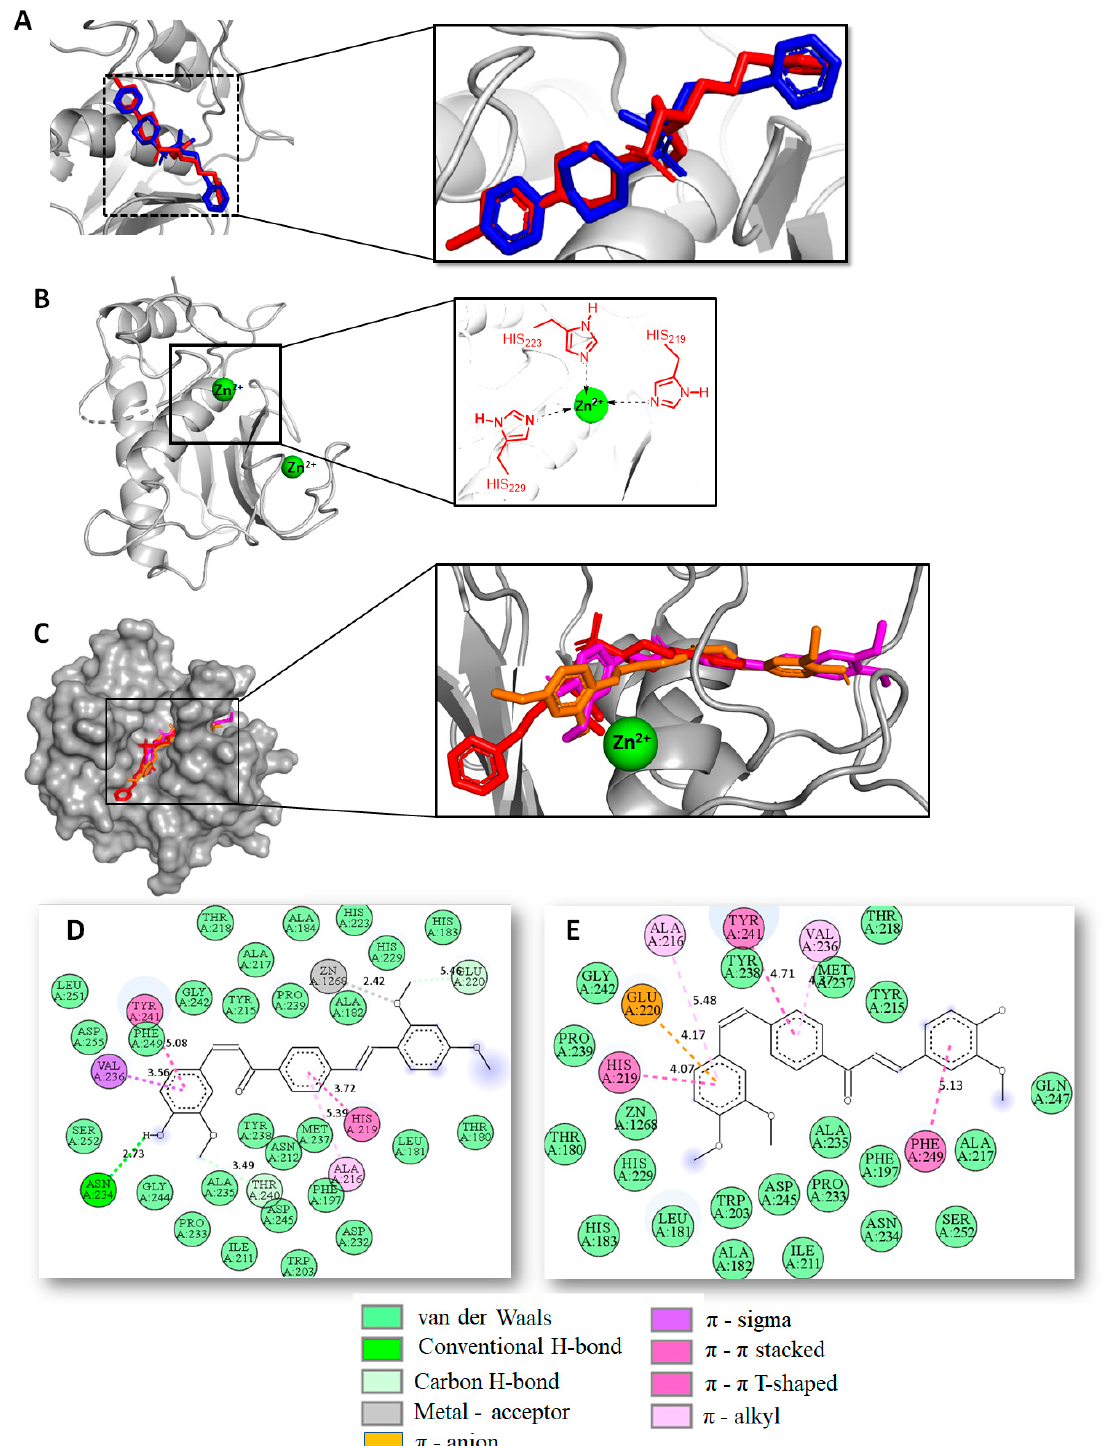
Figure 10. ( A ) A. Self-docking validation. Alignment of the best-docked pose of the hydroxamate ligand inhibitor (HLI) (in blue) and the crystallographic binding mode (in red). ( B ) Histidine triad chelates zinc into the catalytic domain of MMP-7. The catalytic zinc is represented by a green sphere. ( C ) Superposition of the best binding modes of hybrids 3e (orange) and 3i (magenta), and crystallographic binding mode of co-crystalized hydroxamate MMP-7 inhibitor (red) within the MMP-7 catalytic site. ( D , E ) 2D protein–ligand plot interaction for 3e and 3i into the MMP-7 active domain.